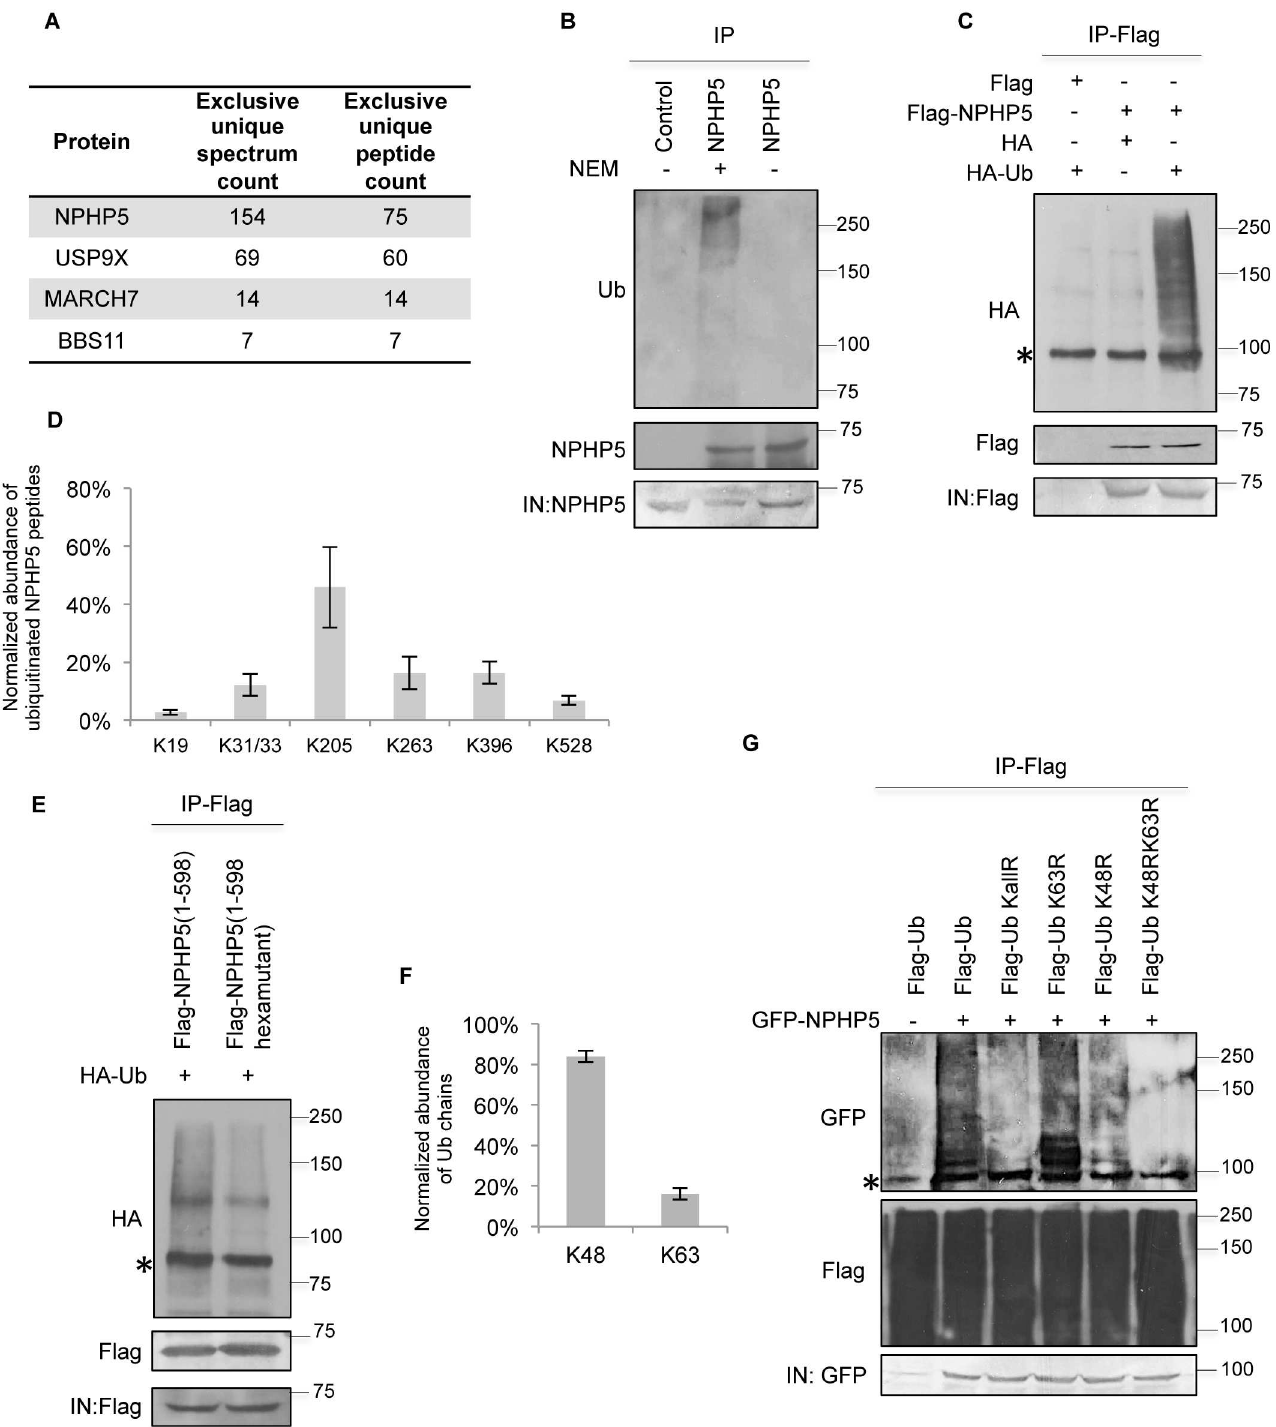
Fig 1. NPHP5 is polyubiquitinated in cells. A ) Flag-NPHP5 complexes from HEK293cells were immuno-purified and subjectedto mass spectrometric analysis. B) HEK293 cell lysates treated with or without a pan DUB inhibitor NEM were immunoprecipitatedwith anti-IgG (control) or anti-NPHP5 antibody and Western blotted with the indicatedantibodies.IN, input. C) HEK293cells were transfected with Flag or Flag-NPHP5 and HA or HA-Ub. Lysates were immunoprecipitated with anti-Flag antibodyin 1% SDS and Western blotted with the indicatedantibodies. IN, input. D ) Flag-NPHP5 expressedin HEK293 cells was immuo-purified in the presence of NEM. Mass spectrometric quantitation of NPHP5 ubiquitination sites is presented. E ) HEK293cells were transfected with HA-Ub and Flag-NPHP5 wild type or hexamutant(K31RK33RK205RK263RK396RK528R).